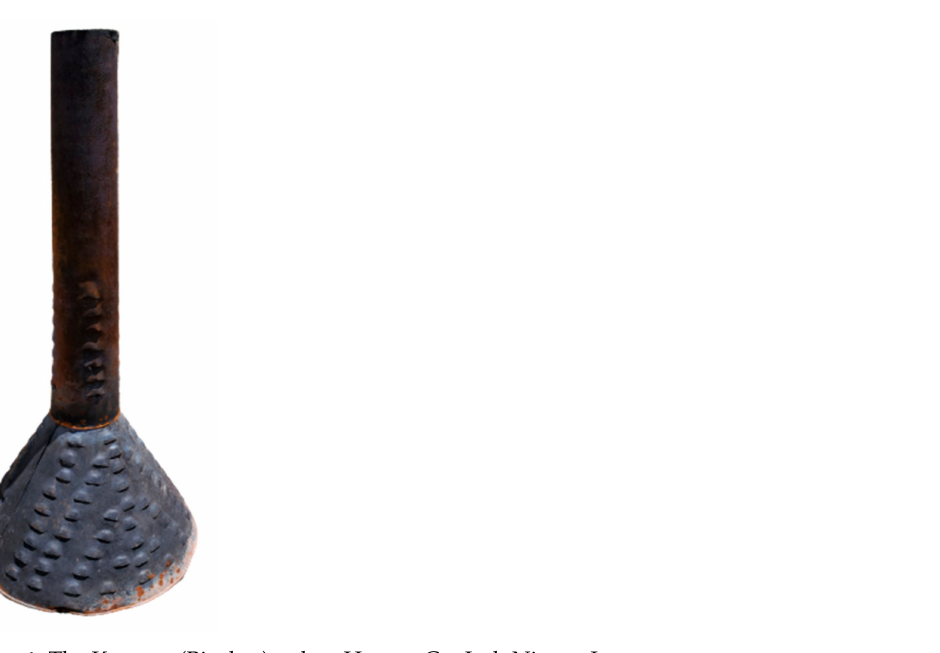
Figure 1. The Kun-tan (Biochar)maker. Honma Co. Ltd. Nigata,